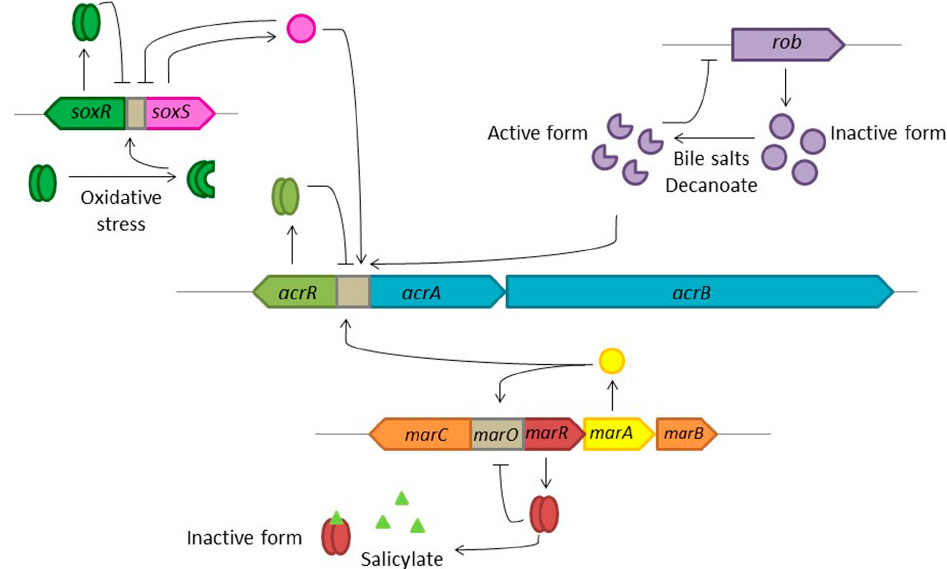
Figure 3. Schematic representation of the regulation of the expression of the E. coli acrAB multidrug efflux pump. AcrAB-TolC is a tripartite complex formed by AcrA, a membrane fusion protein, AcrB, a cytoplasmic membrane protein, and TolC, an outer membrane protein. acrA and acrB are part of the same operon, which is negatively regulated by the dimeric protein AcrR. The global regulators MarA, SoxS, and Rob can activate acrAB expression in response to different environmental signals. MarA is encoded by the second gene of the marRAB operon, the expression of which is repressed by MarR through its binding to its operator marO . The presence of salicylate inactivates MarR, leading to the expression of marRAB . MarA increases its own transcription and activates the expression of acrAB . SoxR and SoxS constitute an oxidative response system [136]. In the absence of signals, the homodimer SoxR represses soxS expression, but under oxidative stress conditions, SoxR is oxidized and becomes an activator of soxS transcription [137]. SoxS binds to the acrAB promoter region and induces its expression. Rob is constitutively expressed but remains in an inactive form, unless an effector such as decanoate or bile salts is present. Those effectors bind and produce conformational changes that activate Rob, inducing acrAB expression.